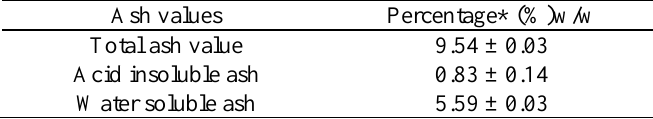
Table 1. Physicochemical Analysis of P. sinjiangensis K. Y. Pan.